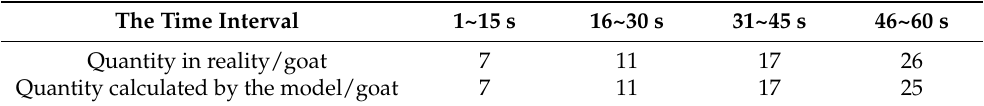
Table 4. Comparison between quantity in reality and quantity calculated by the model. The Time Interval